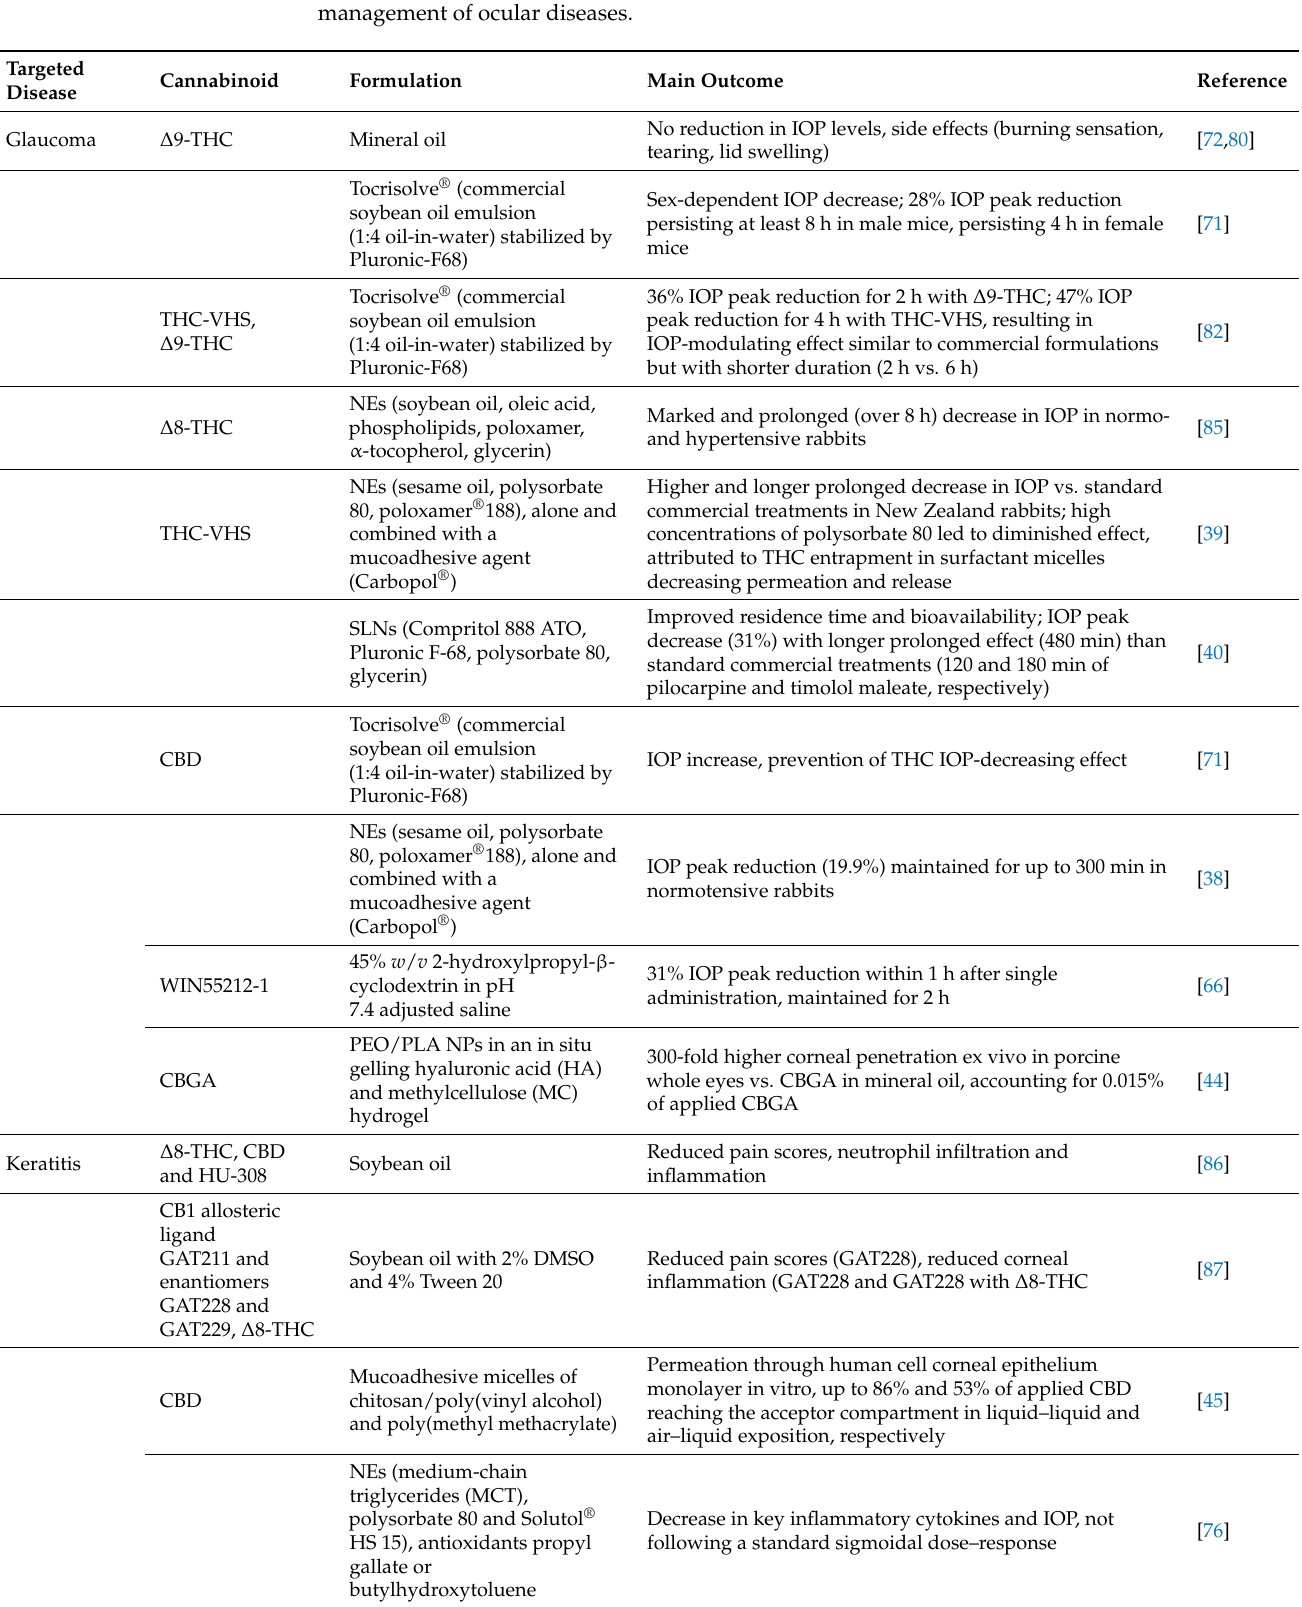
Table 1. Recent cannabinoid formulations designed for topical ophthalmic administration for the management of ocular